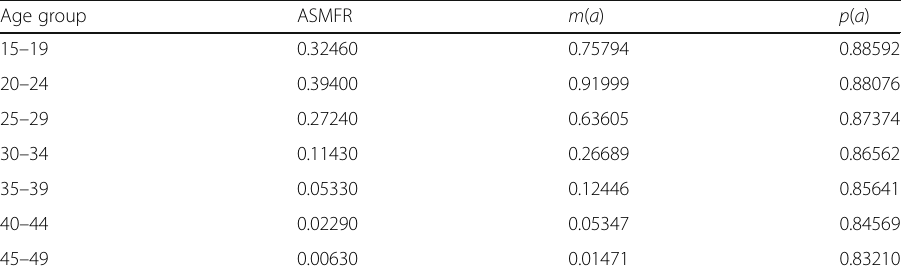
Table 4 The values of age-specific marital fertility rates (ASMFR), values of m ( a ), and p ( a ) values obtained from model life table for each age group Age